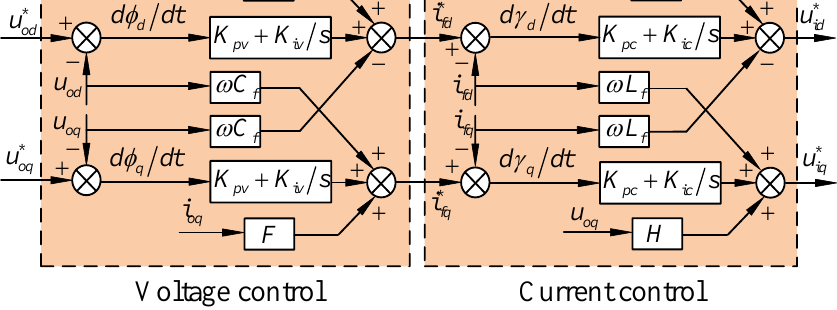
Figure 7. Block diagram of the voltage and current loop control.